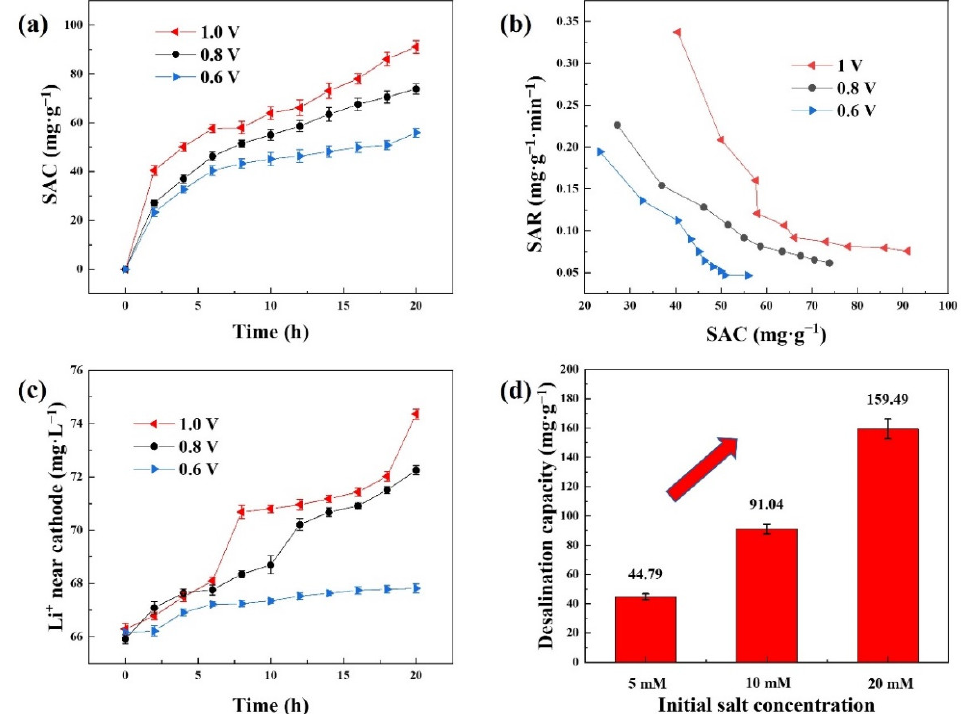
Figure 6. ( a ) Desalination capacities of the CDI cell over 20 h in 10 mM NaCl solution with the constant voltage mode (1.0 V, 0.8 V, 0.6 V); ( b ) SAR-SAC Ragone plots; ( c ) concentration changes of the lithium ions in 10 mM LiCl solution during the CDI processes; ( d ) desalination capacities of different initial NaCl concentrations at 1.0